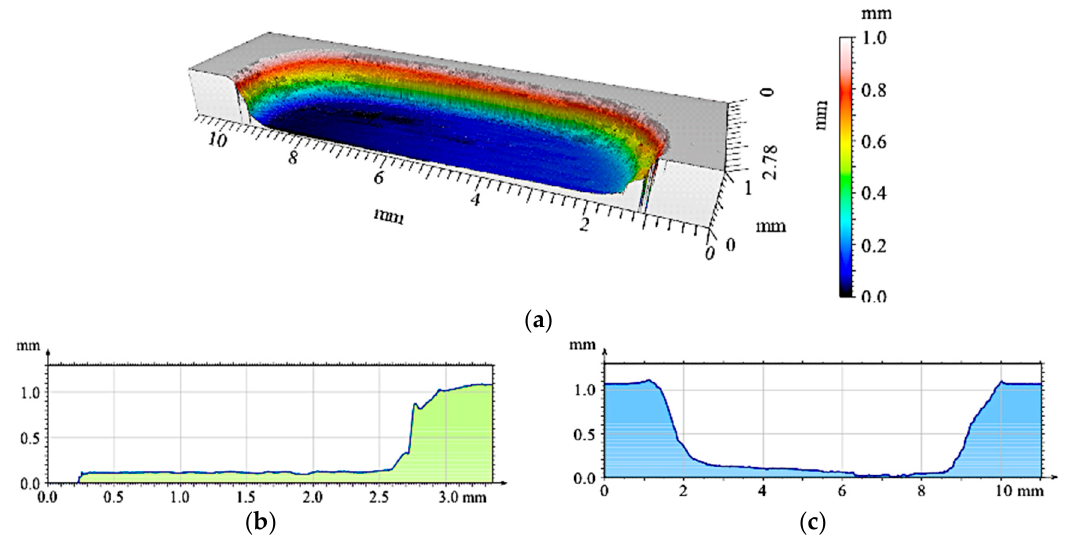
Figure 19. The surface geometry of the single composite layer (C5) after working with a cast iron pin: ( a ) View of the wear track; ( b ) Roughness distribution across the friction direction; ( c ) Roughness distribution along the friction direction.